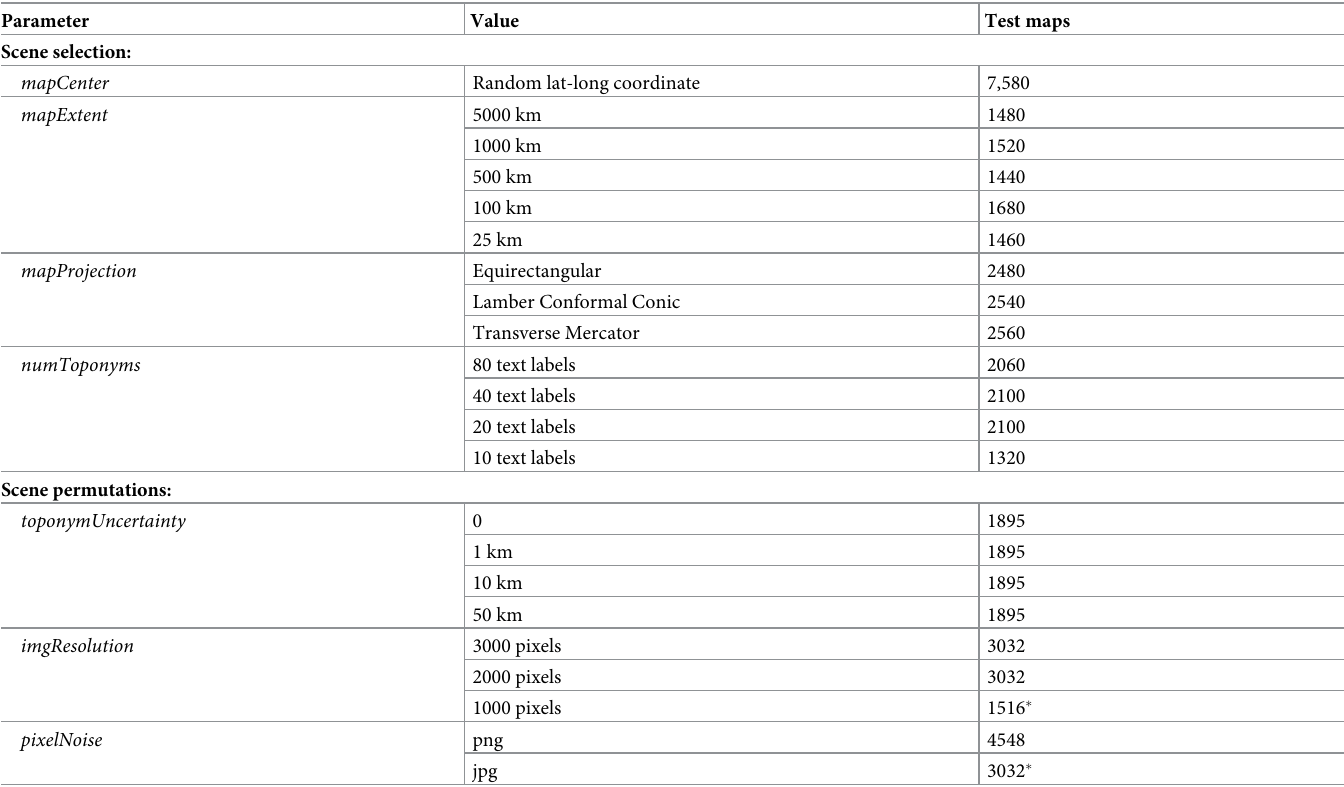
Table 1. Sample sizes of the simulated map